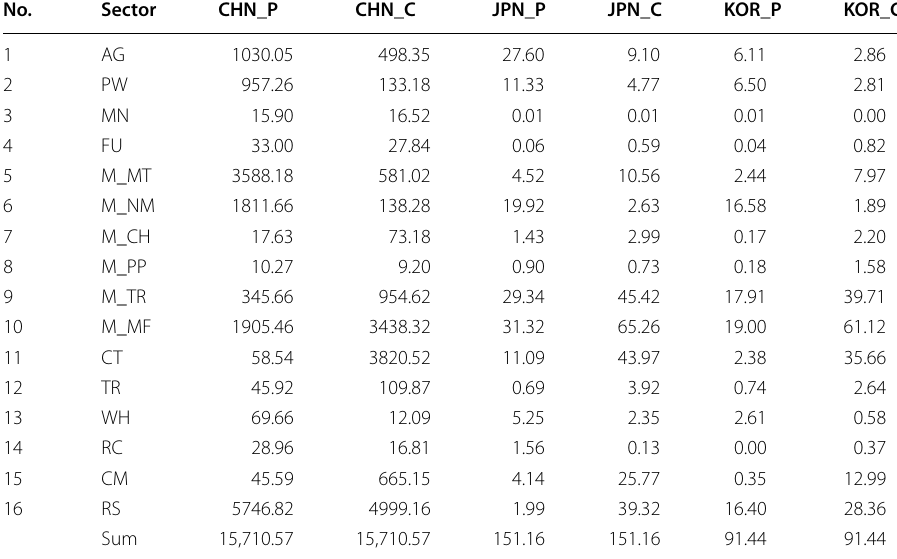
Table 8 PM2.5 emission (in kt) of production and consumption attribution